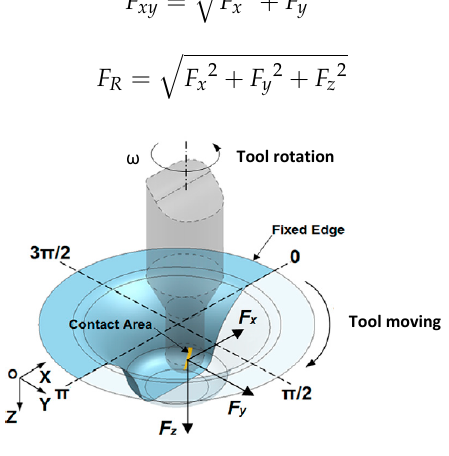
Figure 6. The forming forces in SPIF (modified from [29]).